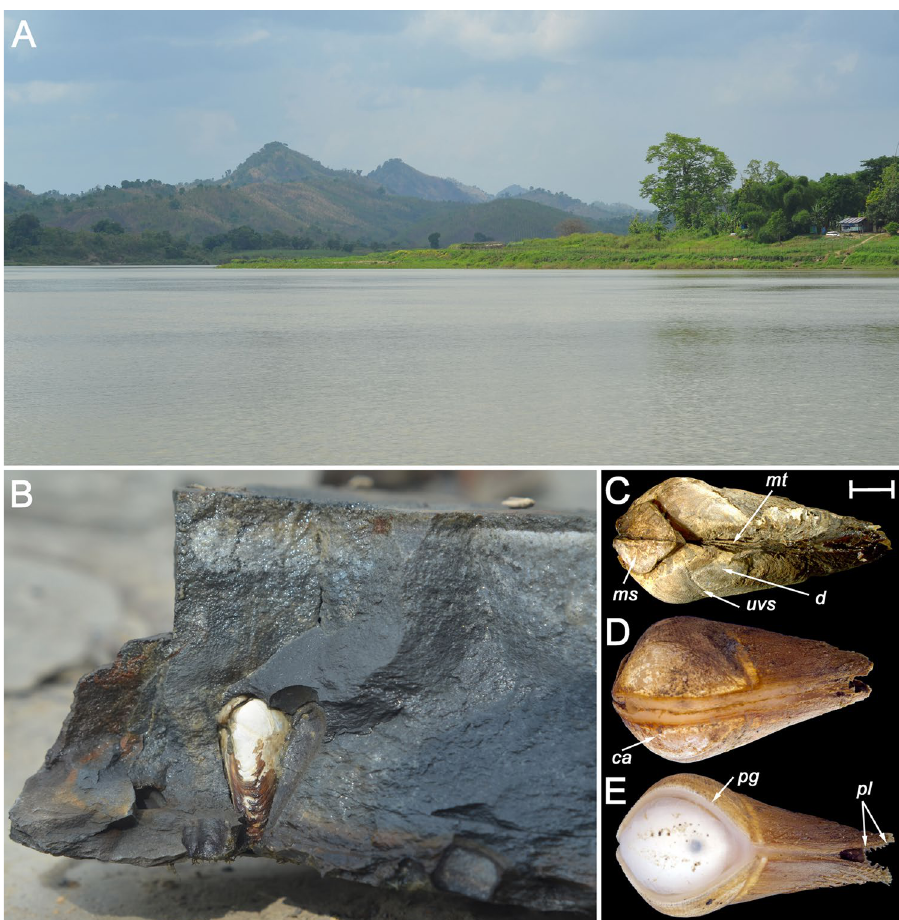
Figure 8. Recent freshwater piddock Lignopholas fluminalis (Blanford, 1867) in the middle reaches of the Kaladan River, Rakhine State, Myanmar 13 . ( A ) Habitat of the freshwater piddock: river pool with siltstone rocks at the bottom, a possible modern analogue of the Mesozoic riverine ecosystem with † Palaeolignopholas . ( B ) Siltstone rock fragment with living freshwater piddocks inside their clavate borings. ( C ) Ethanol-preserved piddock (dorsal view). ( D ) Living piddock with fully developed callum (ventral view). ( E ) Living piddock with pedal gape (ventral view). Abbreviations: d disc; mt metaplax; ms mesoplax; ca callum; uvs umbonal ventral sulcus; pg pedal gape; pl periostracal lamellae. Scale bar = 2 mm. (Photos: Olga V.